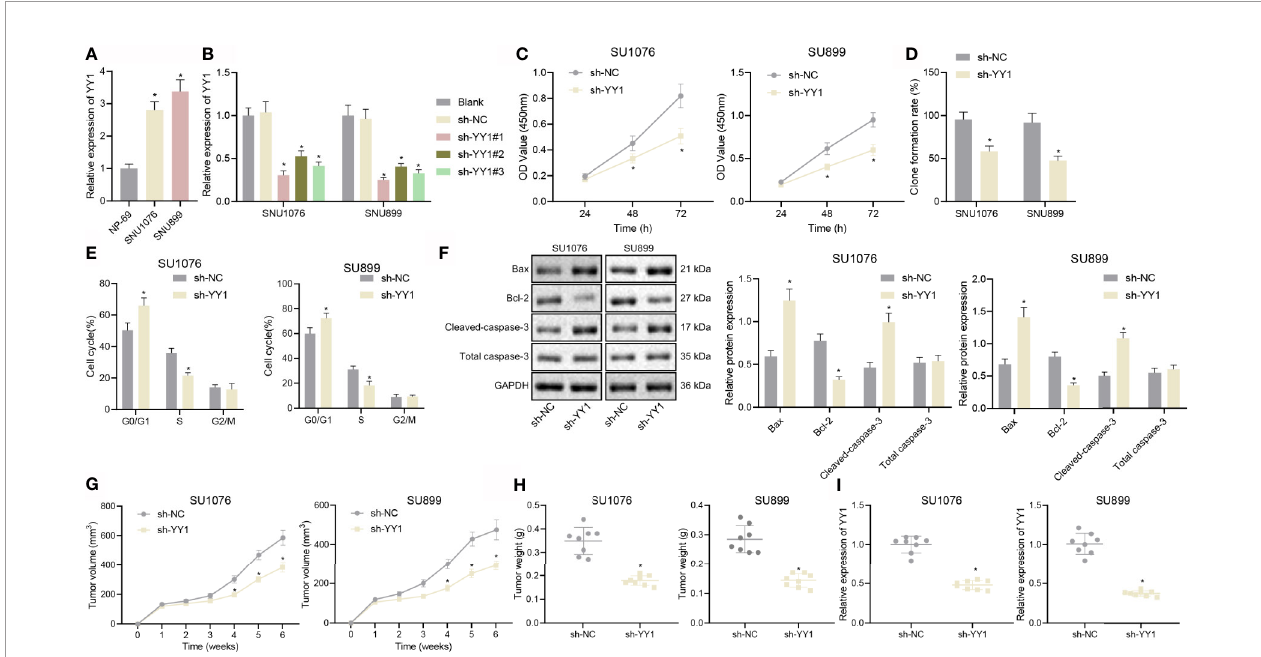
FIGURE 2 | YY1 promotes LSCC cell proliferation and tumor growth but inhibits LSCC cell apoptosis. (A) mRNA expression of YY1 in NP-69, SNU1076, and SNU899 cells determined by RT-qPCR, * indicates p < 0.05 compared with NP-69. (B) mRNA expression of YY1 in SNU1076 and SNU899 cells transfected with sh-YY1#1, sh-YY1#2, and sh-YY13 determined by RT-qPCR. (C) Proliferation of SNU1076 and SNU899 cells measured by CCK-8 assay. (D) Colony formation of SNU1076 and SNU899 cells measured by colony formation assay. (E) Cell cycle distribution measured by fl ow cytometry in SNU1076 and SNU899 cells. (F) Western blot analysis of Bax, Bcl-2, and cleaved caspase-3 proteins in SNU1076 and SNU899 cells, normalized to GAPDH. (G) Tumor volume curve of mice. (H) Tumor weight of mice. (I) mRNA expression of YY1 in tumor tissues of mice determined by RT-qPCR, * indicates p < 0.05 compared with sh-NC. Data are shown as mean ± standard deviation of three technical replicates. Data between two groups were compared by unpaired t -test while those among multiple groups at varied time points were compared by two-way ANOVA or repeated measures ANOVA with Bonferroni post-hoc tests. n = 8 mice in each treatment